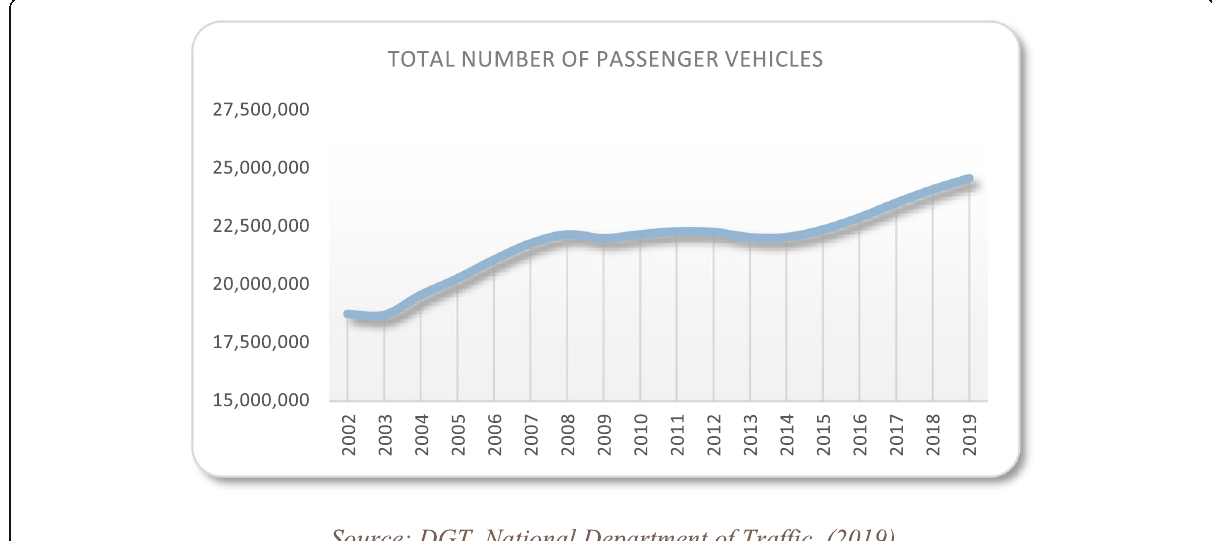
Fig. 11 The total number of passenger vehicles in Spain (2019